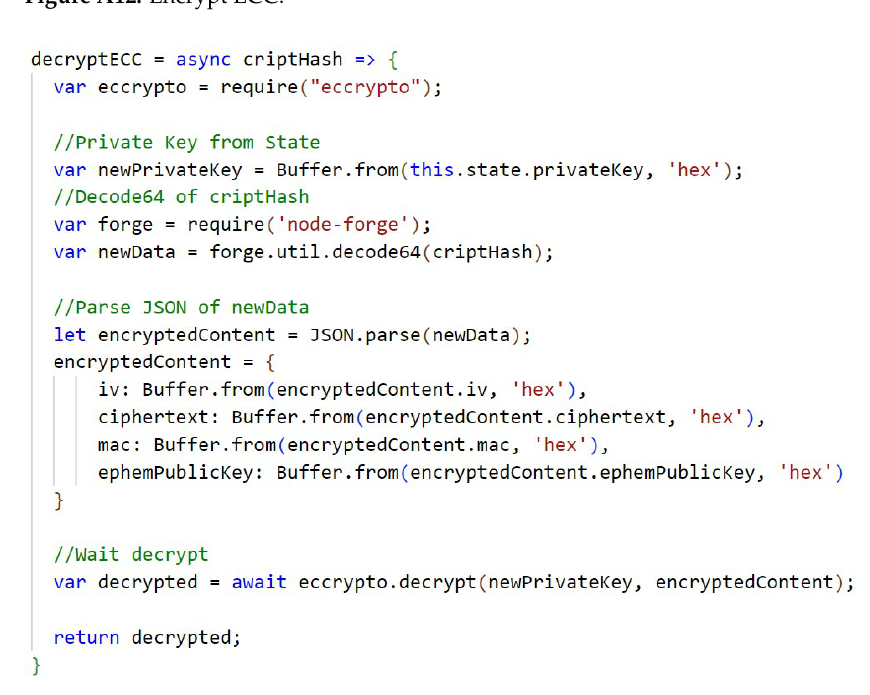
Figure A12. Encrypt ECC.